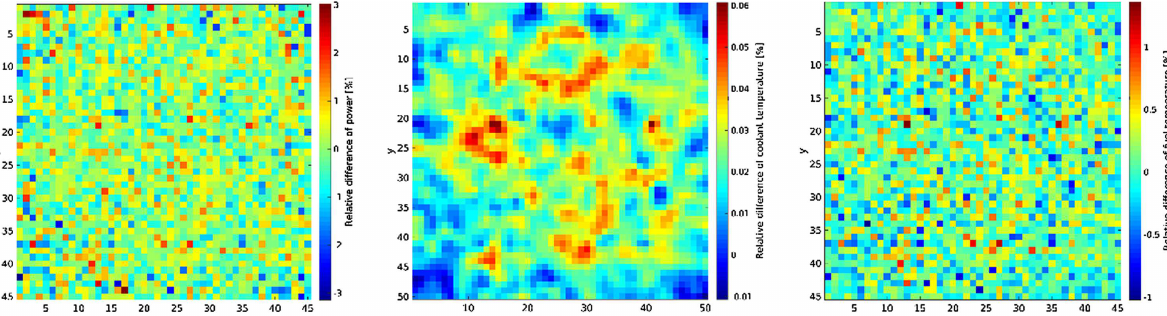
Fig. 13. Comparison of dynamic and static convergence results: relative difference of power output (left), relative difference of coolant temperatures (middle), and relative difference of fuel temperatures